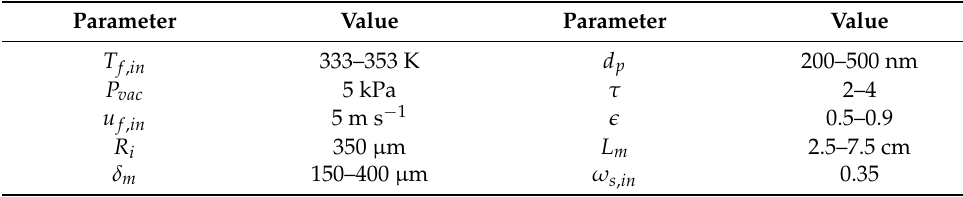
Table 1. Operating parameters and